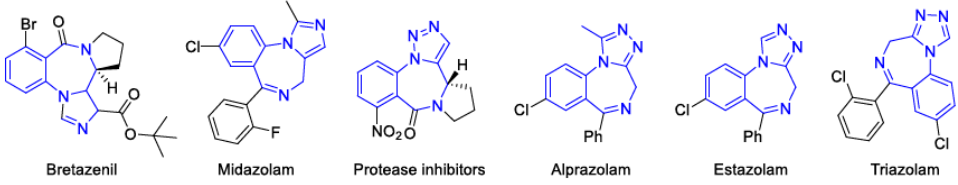
Figure 1. Biologically active triazolobenzodiazepine-related molecules.